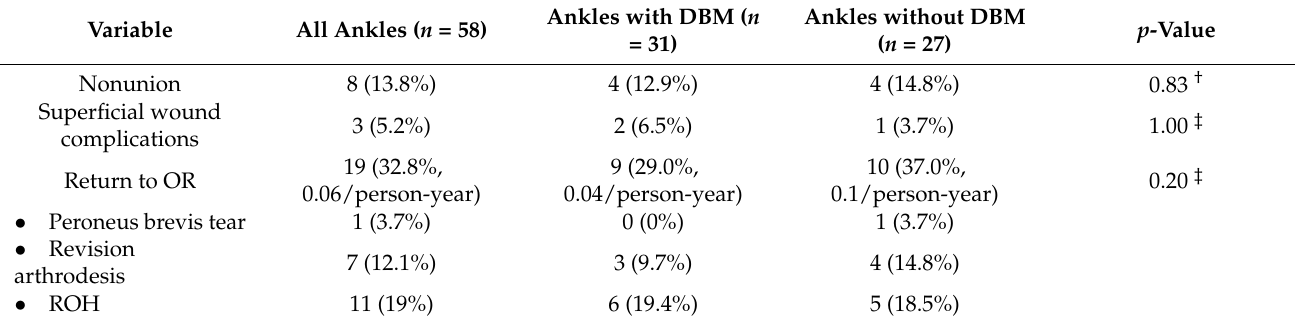
Table 4. Postoperative